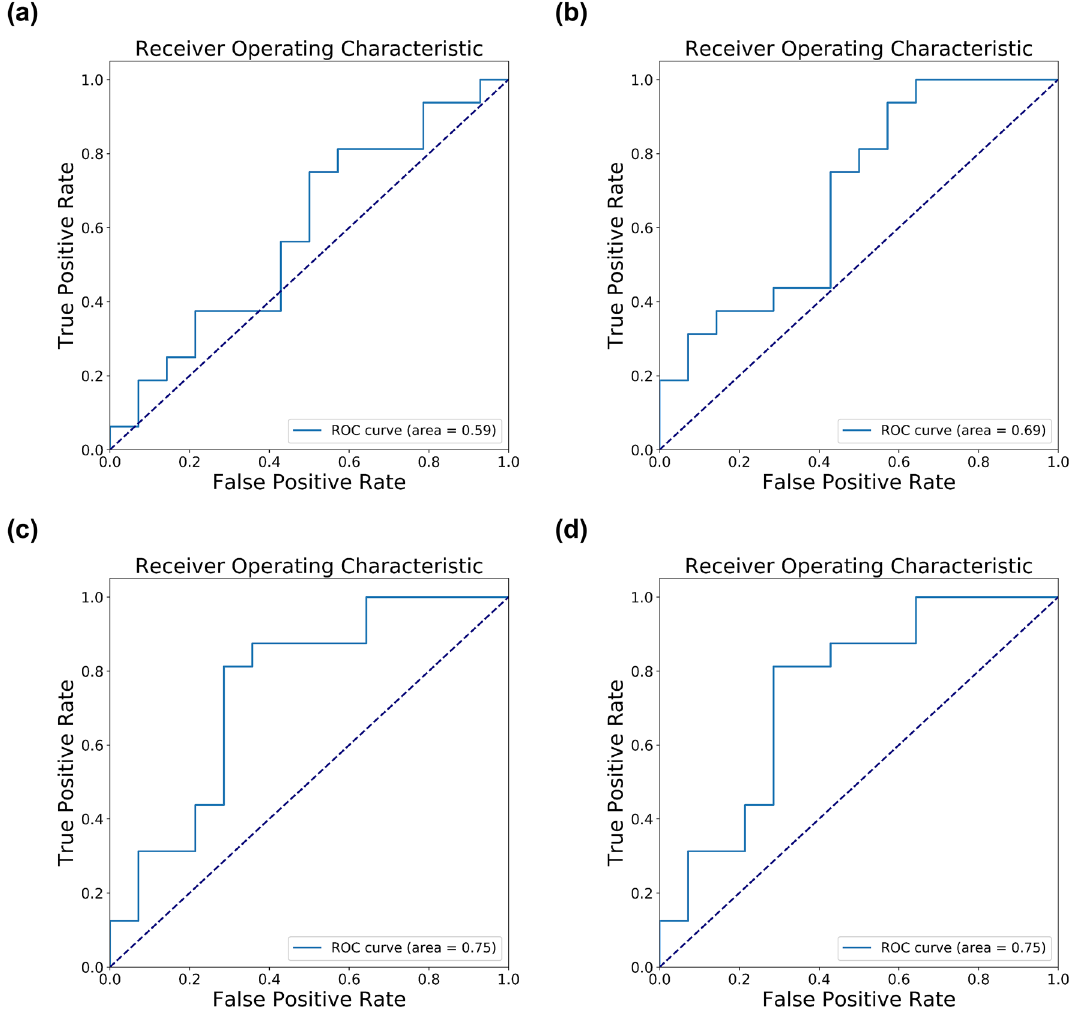
Figure 3. The ROC curve of the test set with microbiota data. ( a ) All features (366) + SVM (rbf). ( b ) Chi- squared test (25) + SVM (rbf). ( c ) Chi-squared test (85) + SVM (rbf). ( d ) Chi-squared test (85) + SVM (rbf), with noise ( I = 0.001) and probability threshold = 0.3. For panel ( a , b ), we only use microbiota data, while for ( c , d ) we also include transcriptome